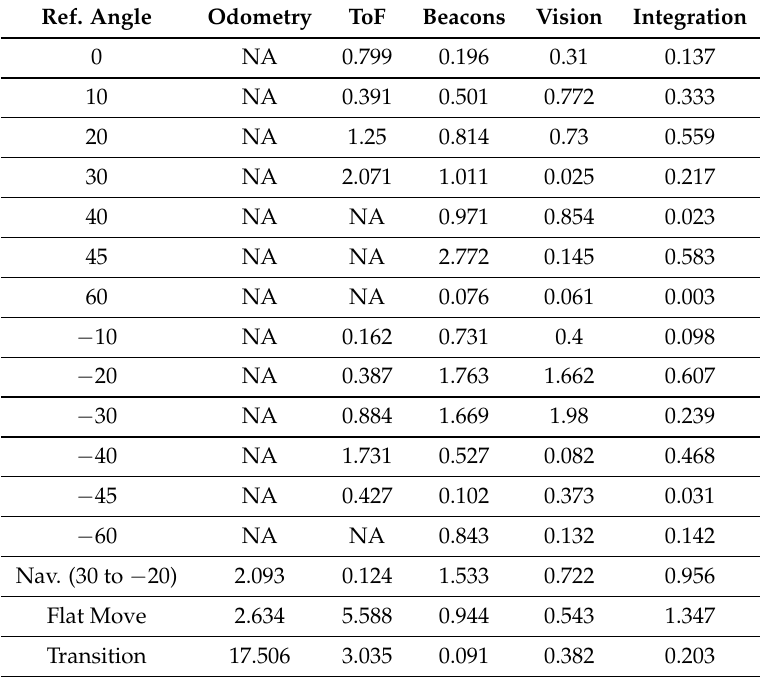
Table 2. Root mean square error (RMSE) comparison of orientation data (degrees). Ref. Angle Odometry ToF Beacons Vision